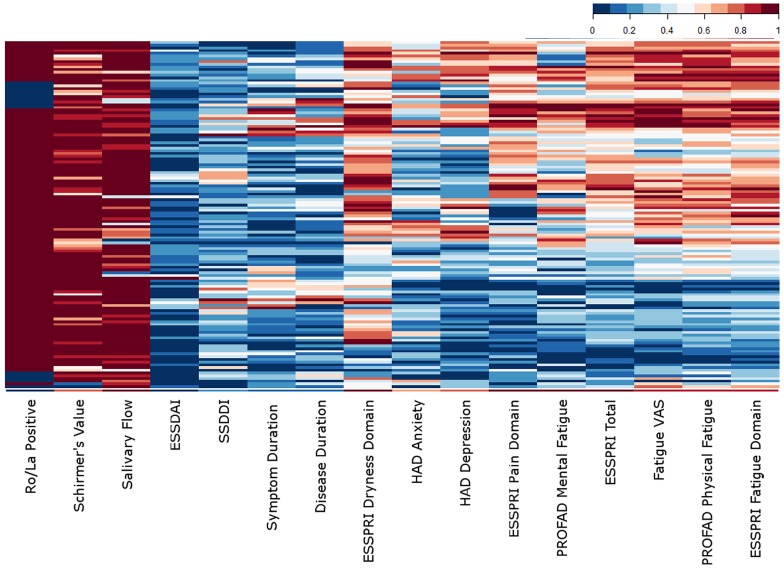
The characteristics of the patients.A heatmap of the clinical scores for the 133 patients included in this study. The values have been scaled between zero (absent) and one (worst). ESSDAI = EULAR Sjögren’s Syndrome Disease Activity Index, SSDDI = Sjögren’s Syndrome Disease Damage Index, ESSPRI = EULAR Sjögren’s Syndrome Patient Reported Index, HAD = Hospital Anxiety and Depression, PROFAD = Profile of Fatigue and Discomfort, VAS = Visual Analogue Scale.